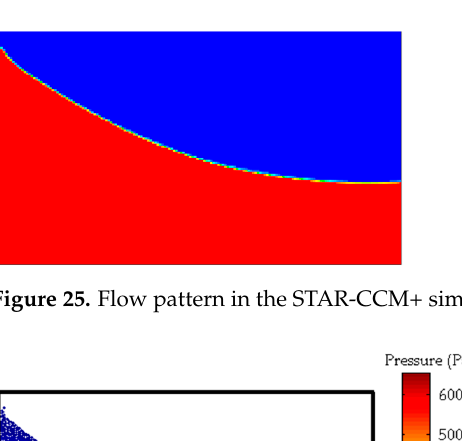
Figure 24. Pressure distribution in the STAR-CCM+ simulation without the baffle.